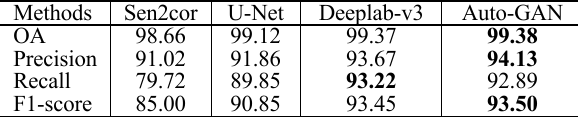
Table 1. Objective evaluation for different